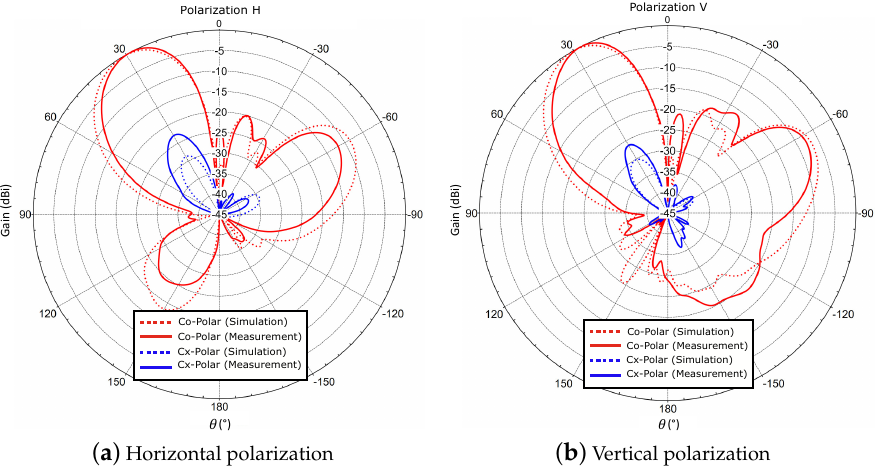
Figure 10. Comparison simulation and measurement @ f 0 = 1.325 GHz: normalized co-polar & cross-polar patterns ( ϕ = 90 ◦ ). Normal array.